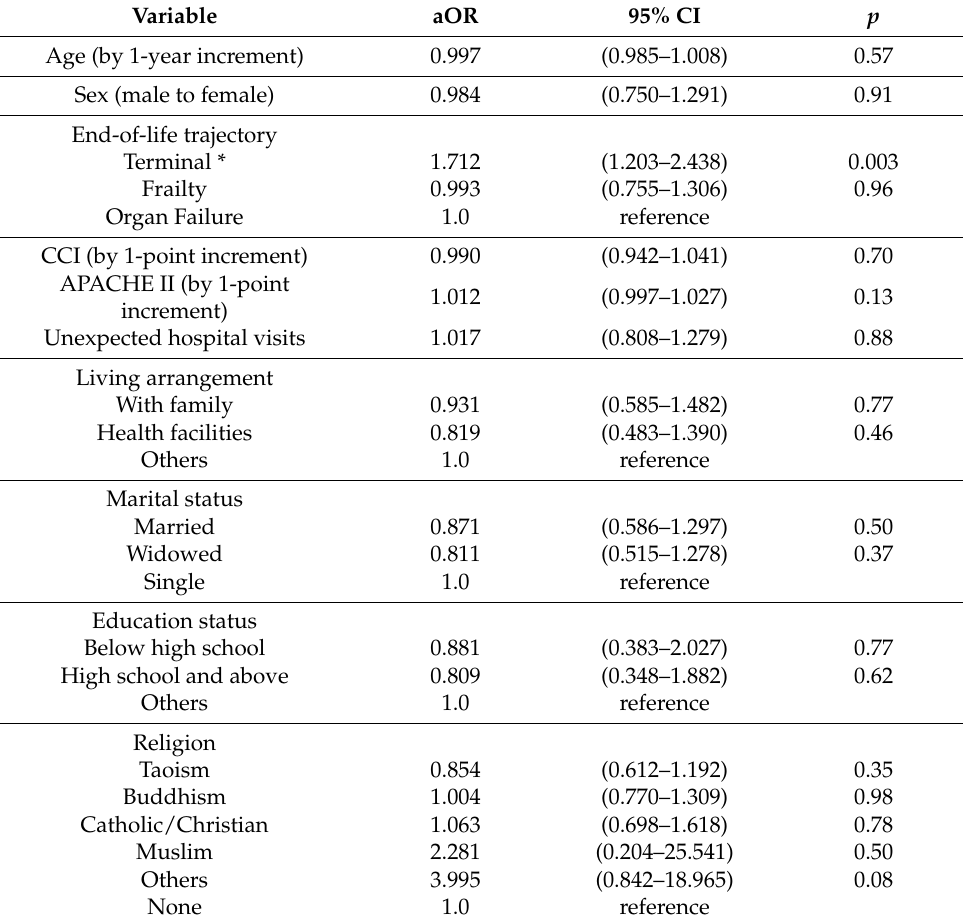
Table 3. Binary logistic regression analyses for acceptance of hospice and palliative care.